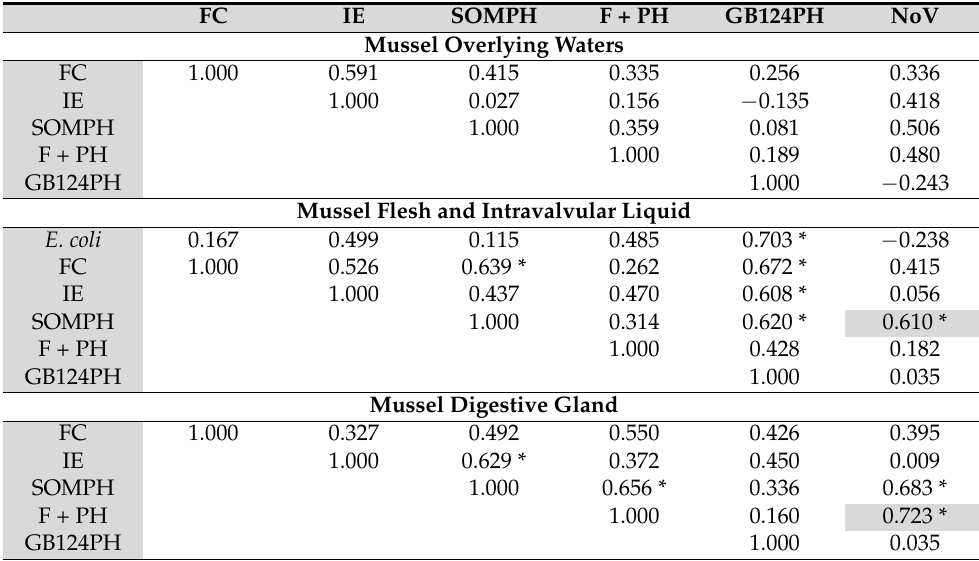
Table 3. ‘Spring/summer’ correlation coefficients (Spearman’s ρ ) between faecal indicators and Norovirus with respect to mussel sample matrix.